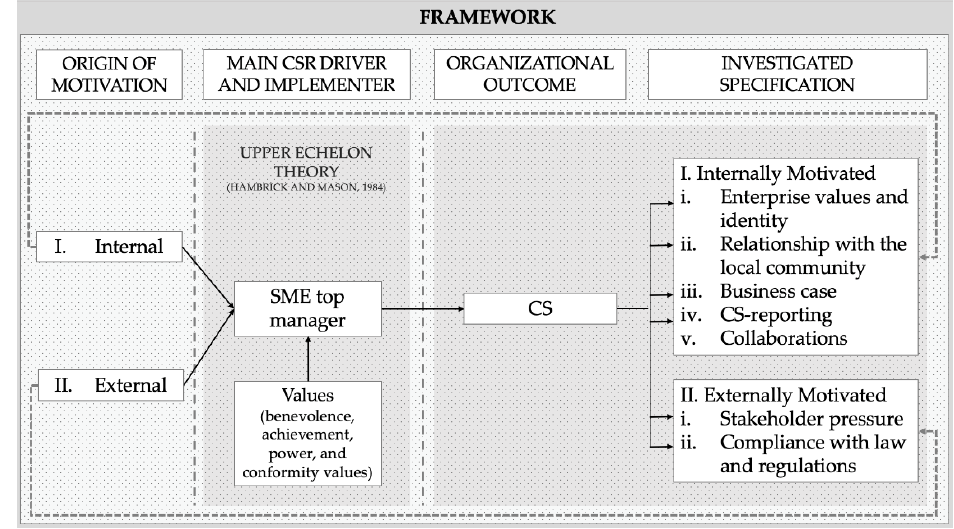
Figure 4. Research framework including the findings. Note: own depiction used according to Dacin et al. (2010) and Colovic et al. (2019).